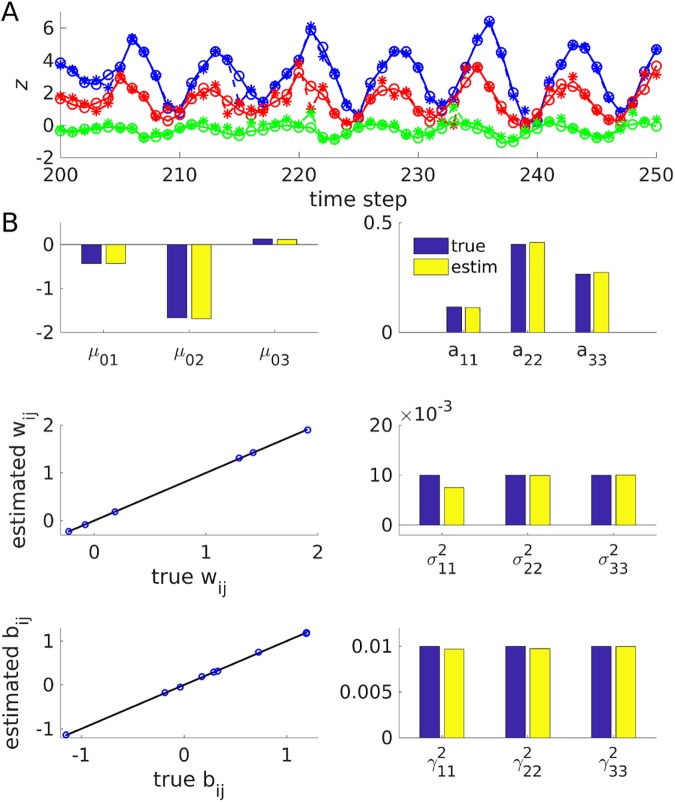
State and parameter estimates for nonlinear cycle example.(A) True (solid/ open-circle lines) and estimated (dashed-star lines) states over some periods of the simulated limit cycle generated by a 3-state PLRNN when true parameters were provided (for this example, θ ≈ (0.86,0.09,–0.85); all other parameters as in B, see also provided Matlab file ‘PLRNNoscParam.mat’). ‘True states’ refers to the actual states from which the observations X were generated. Inputs of sit = 1 were provided to units i = 1 and i = 2 on time steps 1 and 10 of each cycle, respectively. Note that true and inferred states are tightly overlapping in this low-noise example (such that the ‘stars’ appear on top of the ‘open circles’). (B) True and estimated model parameters for (from top-left to bottom-right) μ0,A,W,Σ,B,Γ, when true states (but not their higher-order moments) were provided. Bisectrix lines (black) indicate identity.